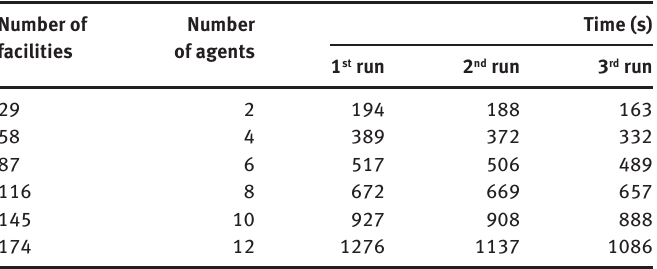
Table 4: Processing Time for Different Instance Sizes of the Static